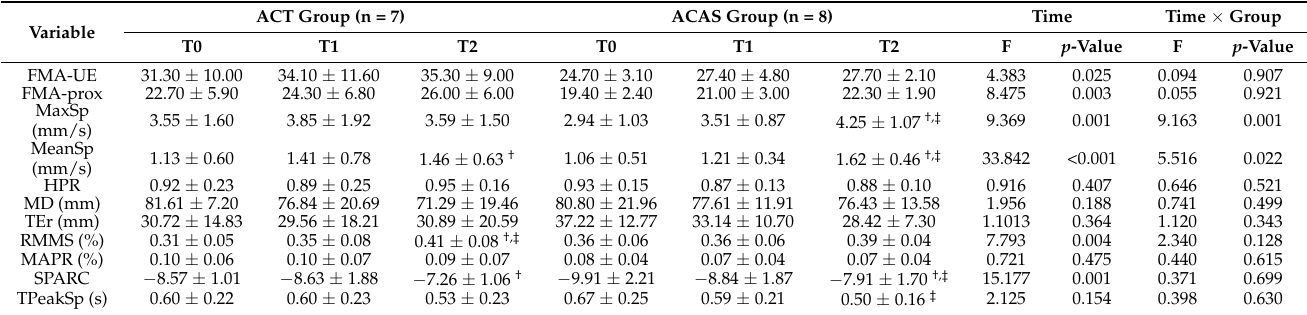
Table 3. Comparison of performance between the ACT and ACAS groups at T0, T1, and T2.